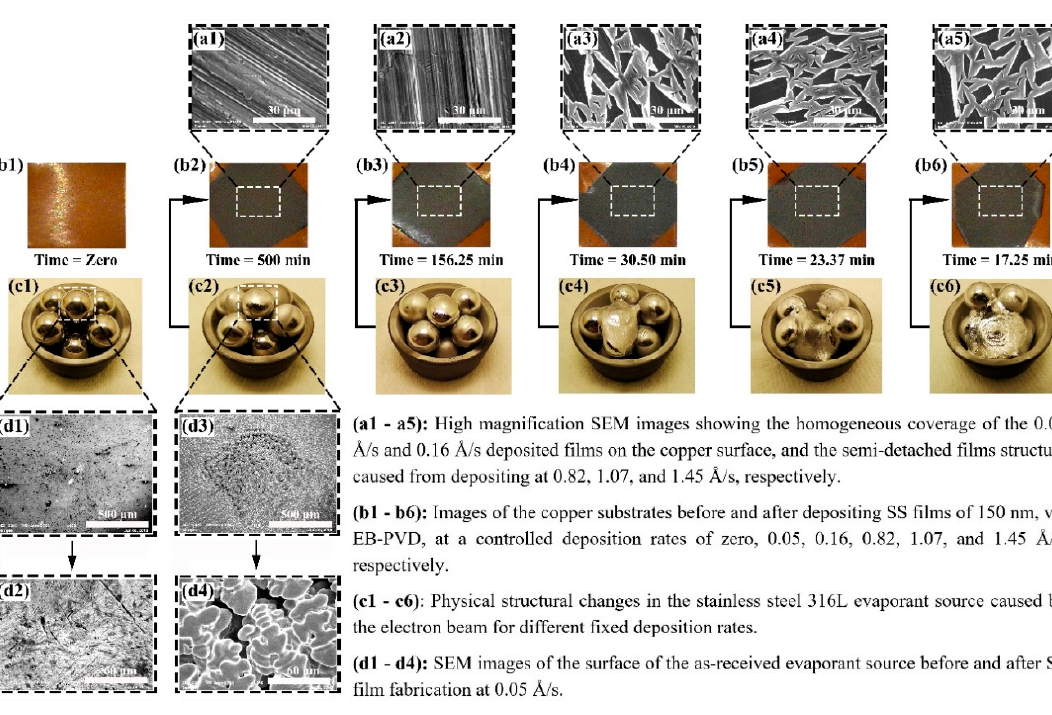
Figure 3. Characterisation of the Stainless steel evaporant source and deposited thin films, where ( a1 – a5 ) shows the SEM images of the 0.05–1.45 Å/s as-deposited films structure, ( b1 – b6 ) illustrates the copper substrates before and after SS deposition, ( c1 – c6 ) demonstrates the physical changes in evaporant source caused by different deposition rates, and ( d1 – d4 ) shows the SEM images of the evaporant source before and after 0.05 Å/s film deposition.